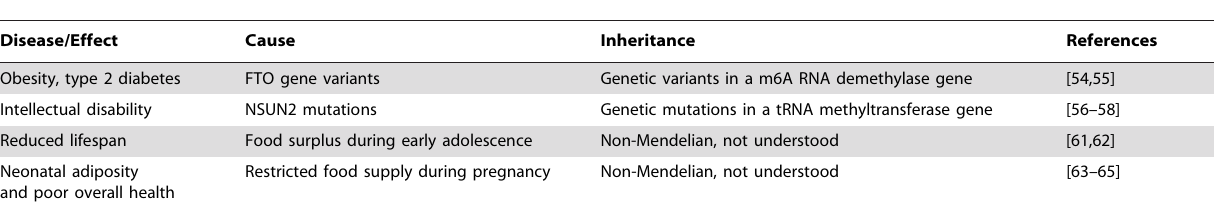
Table 1. Potential links between heritable RNAs and human health and